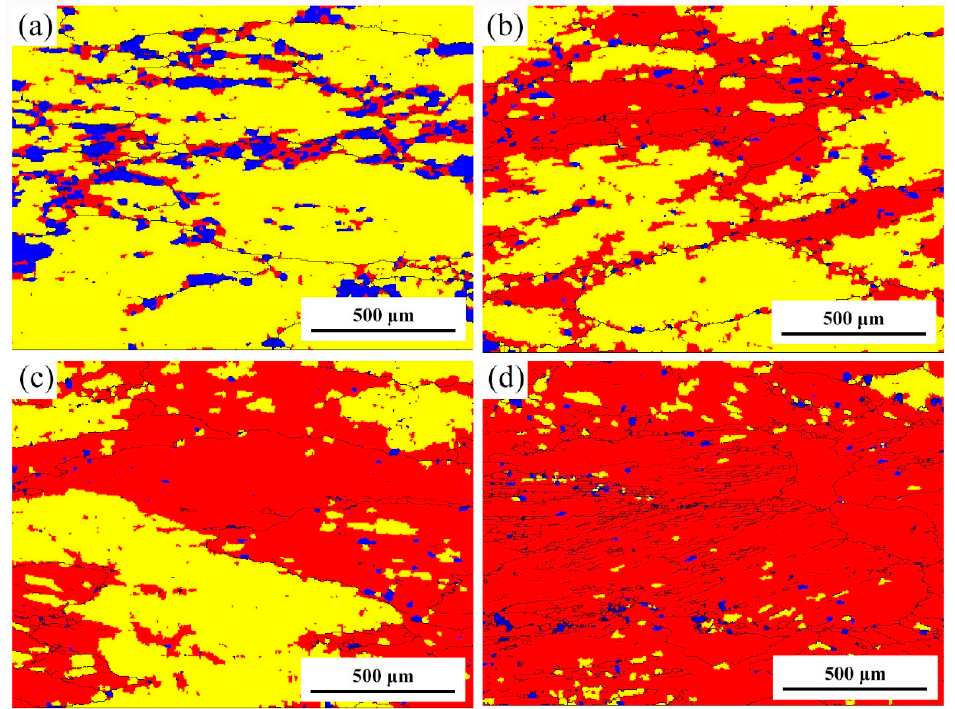
Figure 7. Regions with different misorientation angles in the deformed microstructures under different parameters. ( a ) 500 ◦ C/0.01 s − 1 (ln Z = 20.9); ( b ) 450 ◦ C /0.1 s − 1 (ln Z = 25); ( c ) 450 ◦ C/1 s − 1 (ln Z = 27.3); and, ( d ) 450 ◦ C /10 s − 1 (ln Z = 29.6).